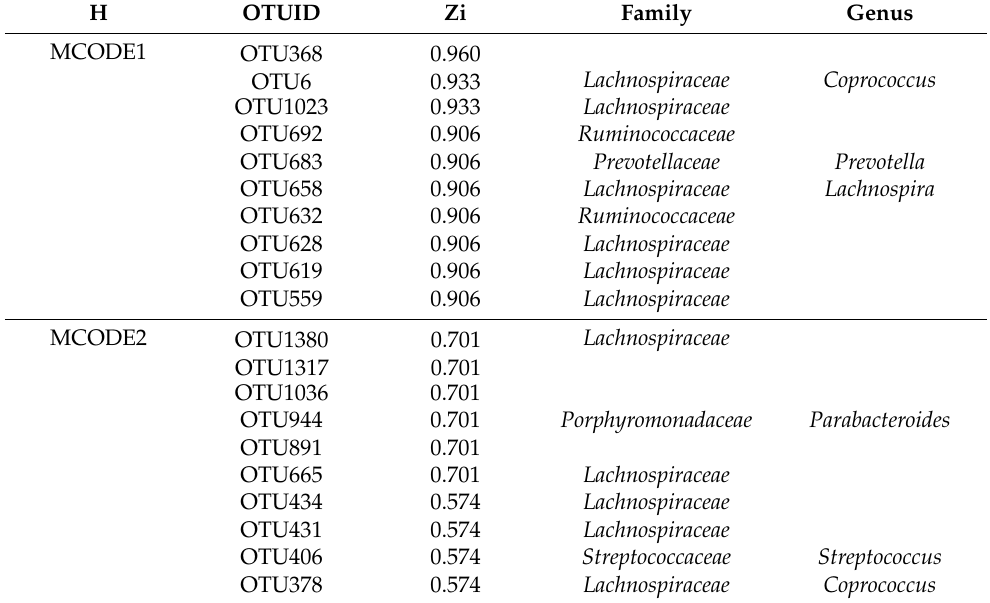
Table A9. Core colonies and corresponding Zi values in each module of H group in network analysis.